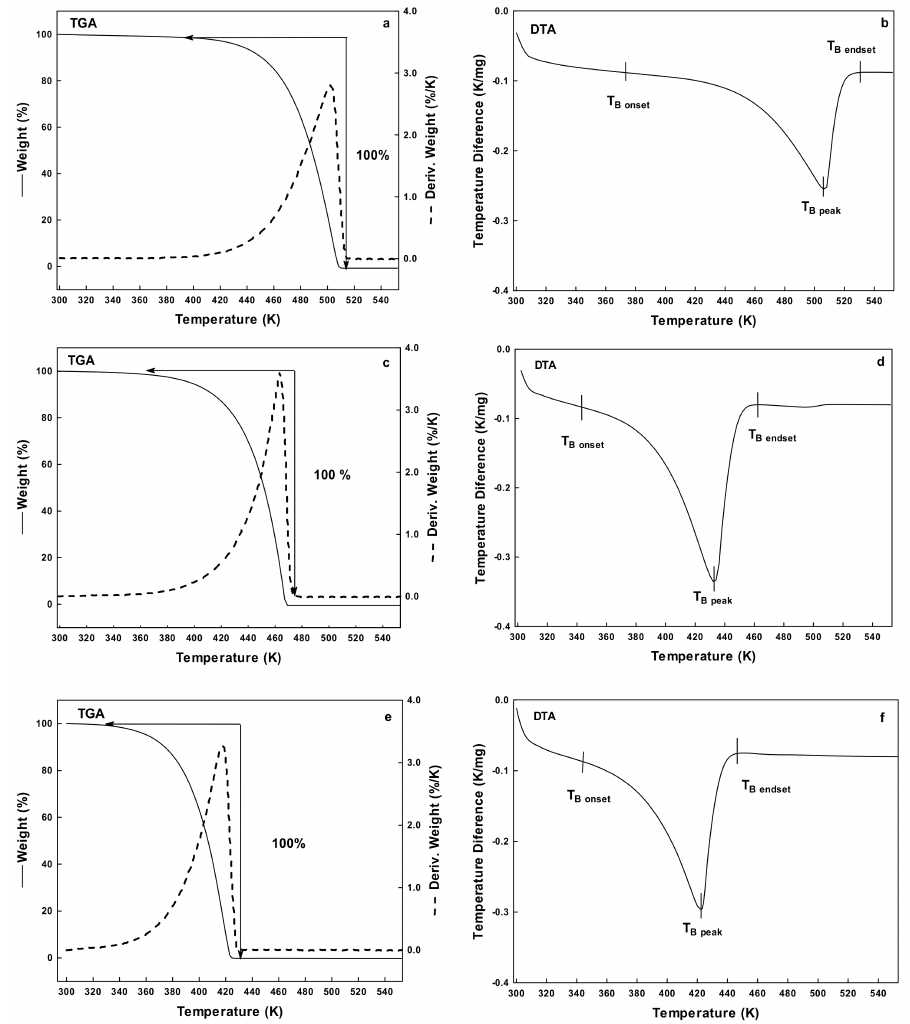
Figure 1. Simultaneous TGA-DTA results at a heating rate of 278 K/min: ( a , b ) GL; and ( c , d ) EG; and ( e , f ) PG. On the left column are plotted the mass loss curve (wt %) (continuous line), and the derivative of mass loss with temperature (%/K) (dotted line). On the right column is plotted the corresponding DTA